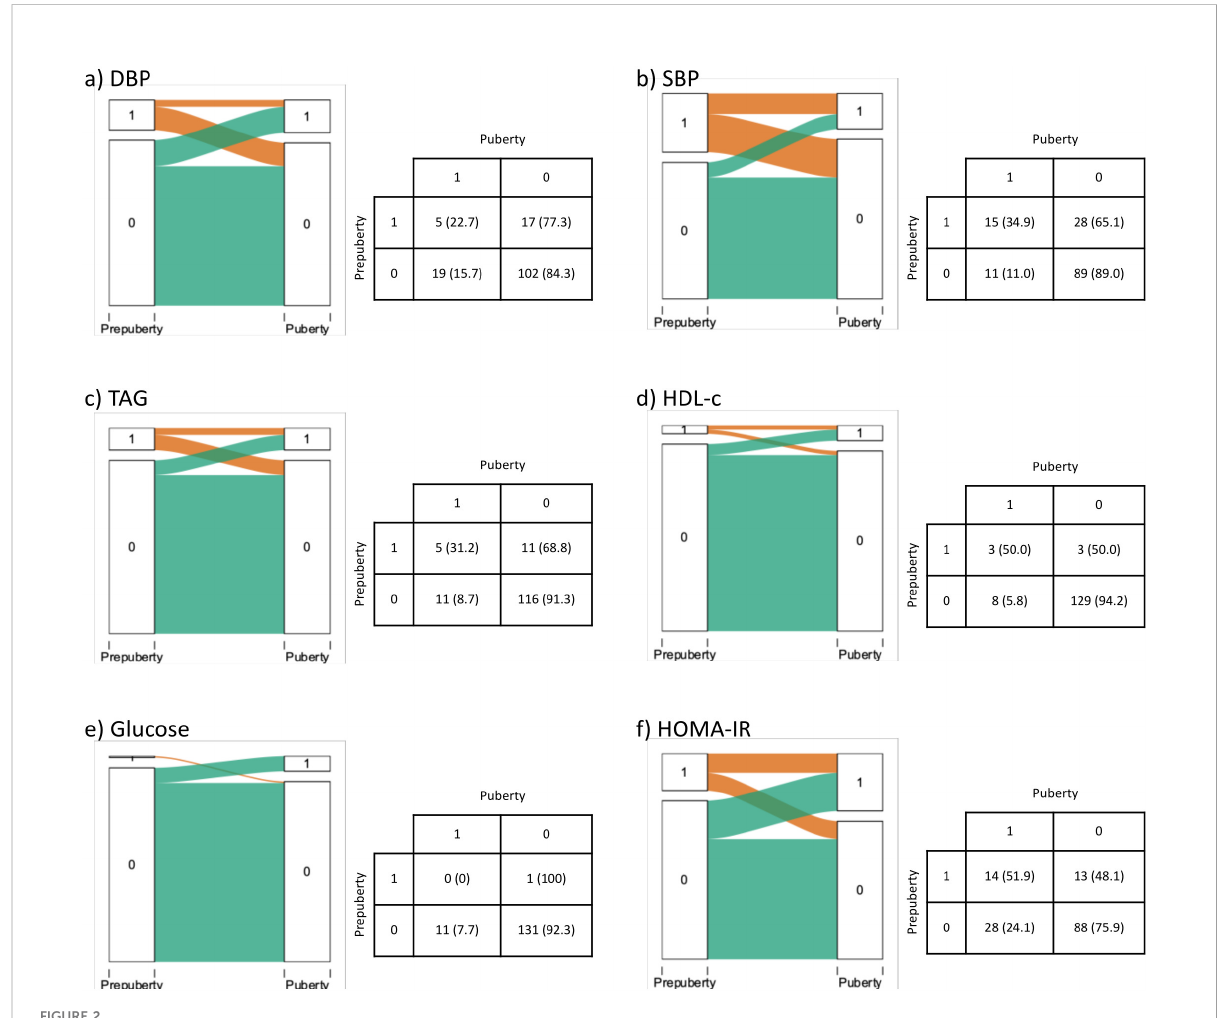
FIGURE 2 Progression of (A) DBP, (B) SBP, (C) TAG, (D) HDL-c, (E) Glucose and (F) HOMA-IR from prepuberty to puberty. 1 Indicates above the threshold, 0 below the threshold according to Olza et al. (6). Statistics presented: n (%). DBP, Diastolic blood pressure: HDL-c, High-Density Lipoprotein cholesterol: HOMA-IR, homeostasis model assessment of insulin resistance: SBP, Systolic blood pressure: TAG,